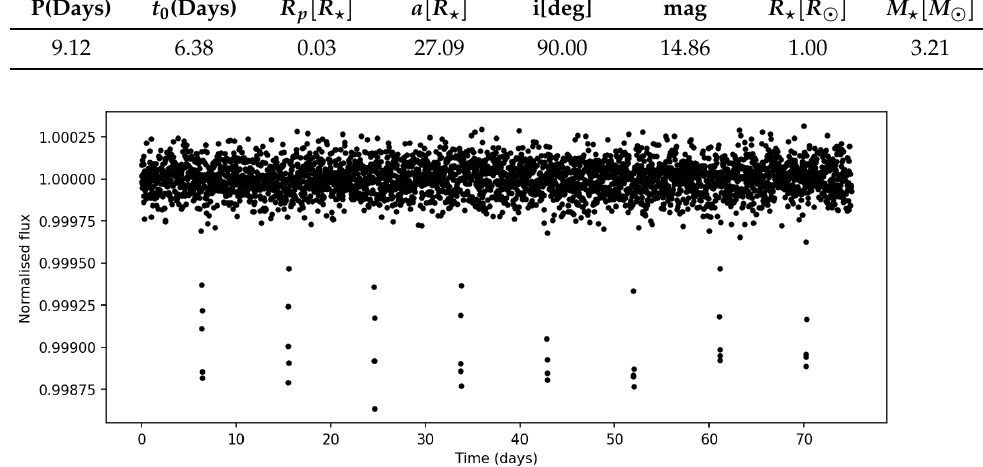
Figure 4. Simulated light curve of host star of the planetary system of Table 1.